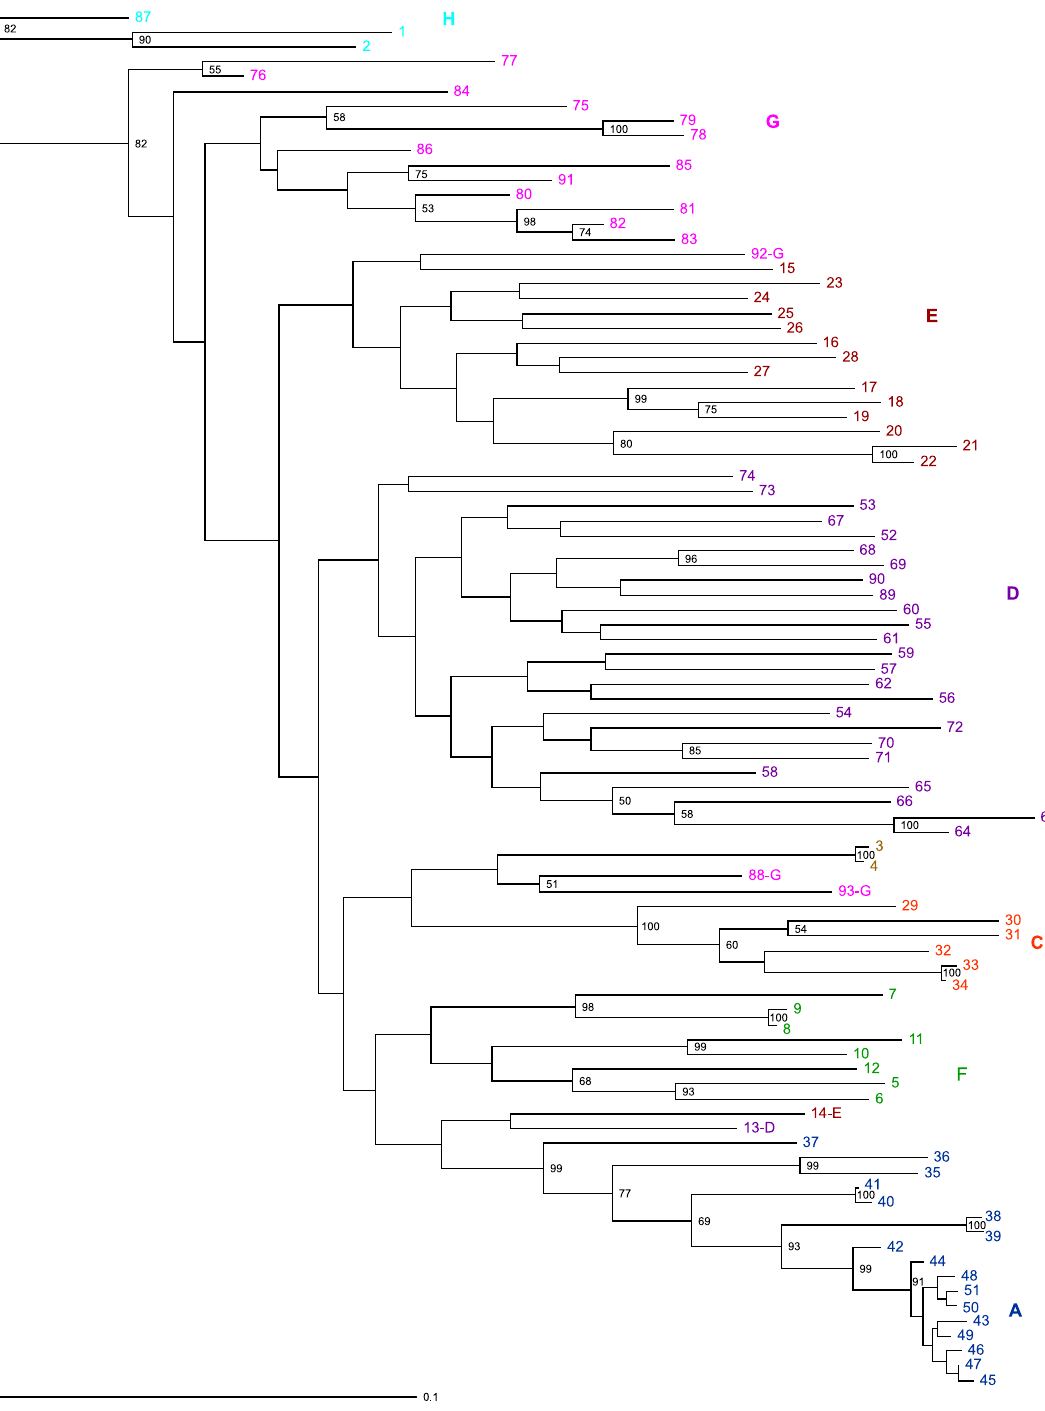
Figure 4. Maximum likelihood phylogenetic analysis of Zanthoxylum accessions. The colour scheme is the same as in Fig. 3. The numbers at the nodes indicate bootstrap values (% over 1000 replicates). The nodes with ≥ 50% bootstrap value are labeled. Figure was generated using Dendroscope (version 3.6.3) 48 and